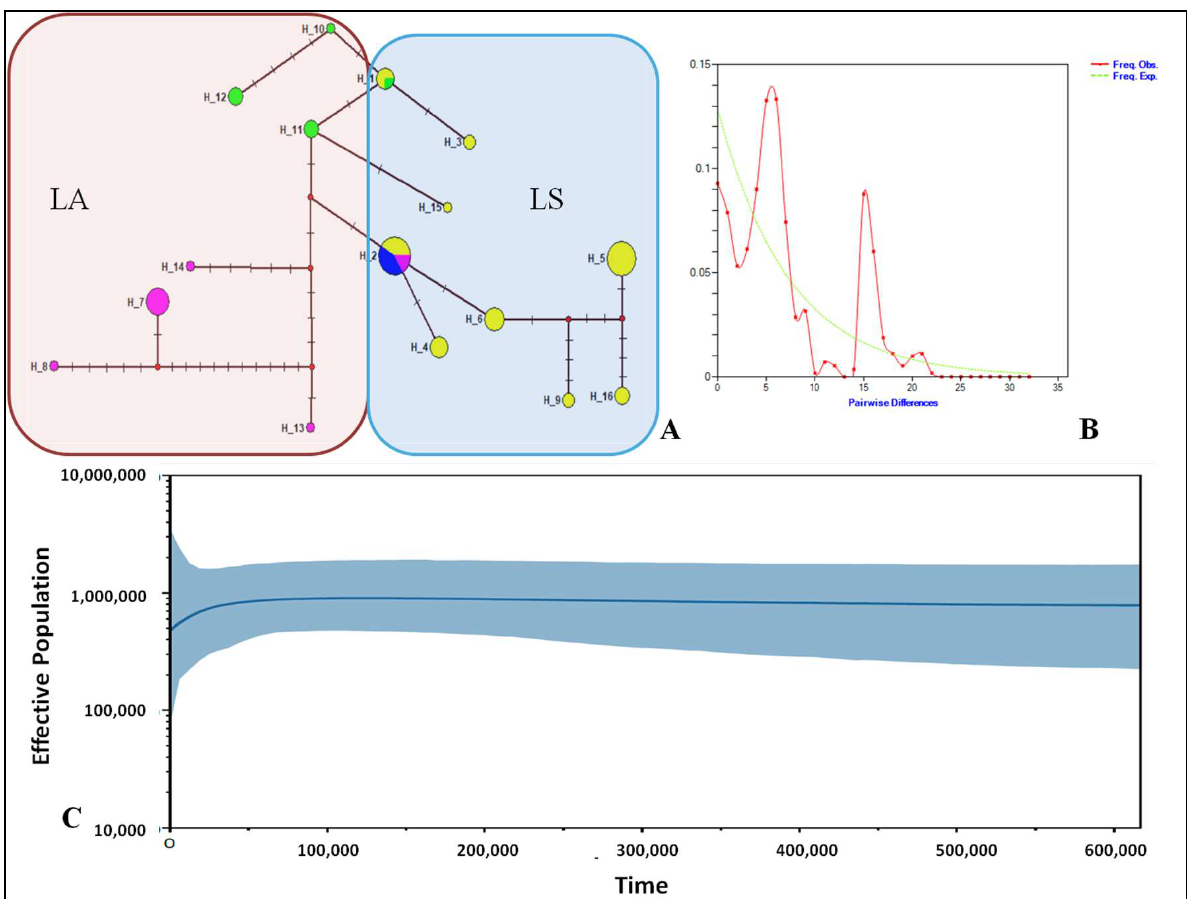
Figure 3. ( A ) Haplotype network generated using d-loop gene of ibex in Lahaul-Spiti and Ladakh regions. ( B ) Mismatch modelling curve shows multimodal explaining population equilibrium in past. ( C ) Bayesian skyline plot reveals stable population over last thousand years and shows decline in last ~30 kya.